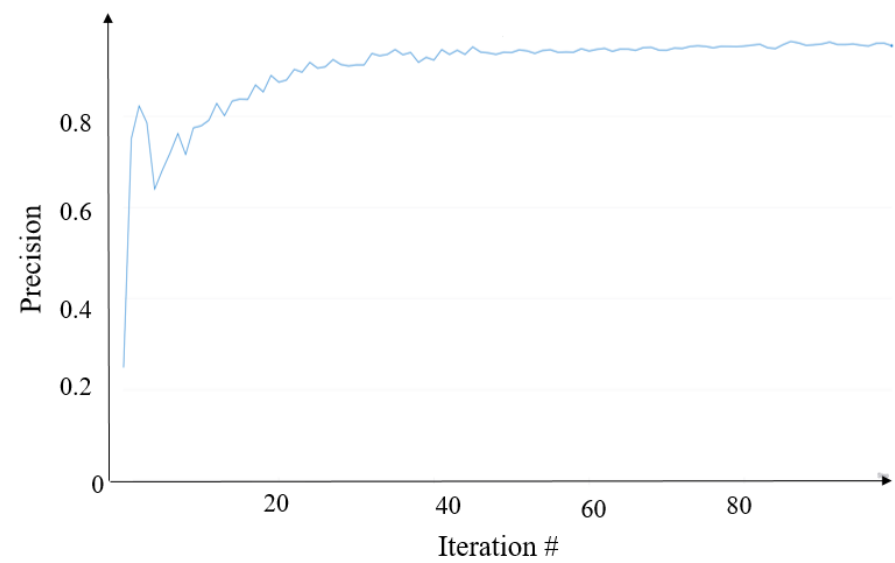
Figure 9. An example of growing precision metric in the iteration process.